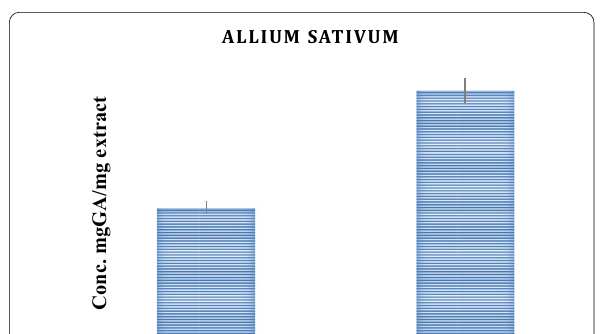
Fig. 2 Total phenolic concentration of the A. sativum